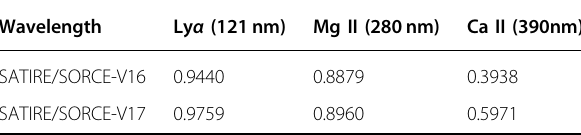
Table 5 Correlation coef fi cients between the SATIRE and SORCE time series for Ly α , Mg II, and Ca II lines as solar activity